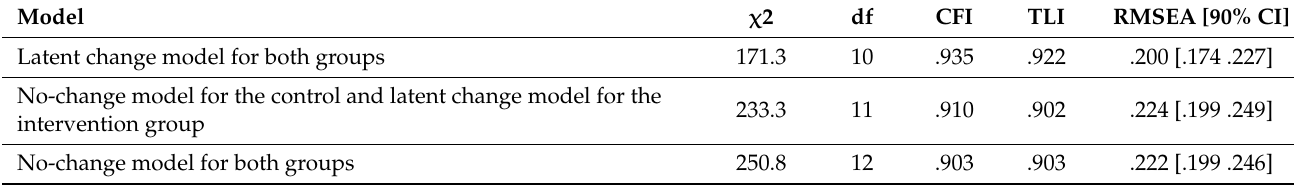
Table 8. Goodness-of-fit indices for the tested models on test